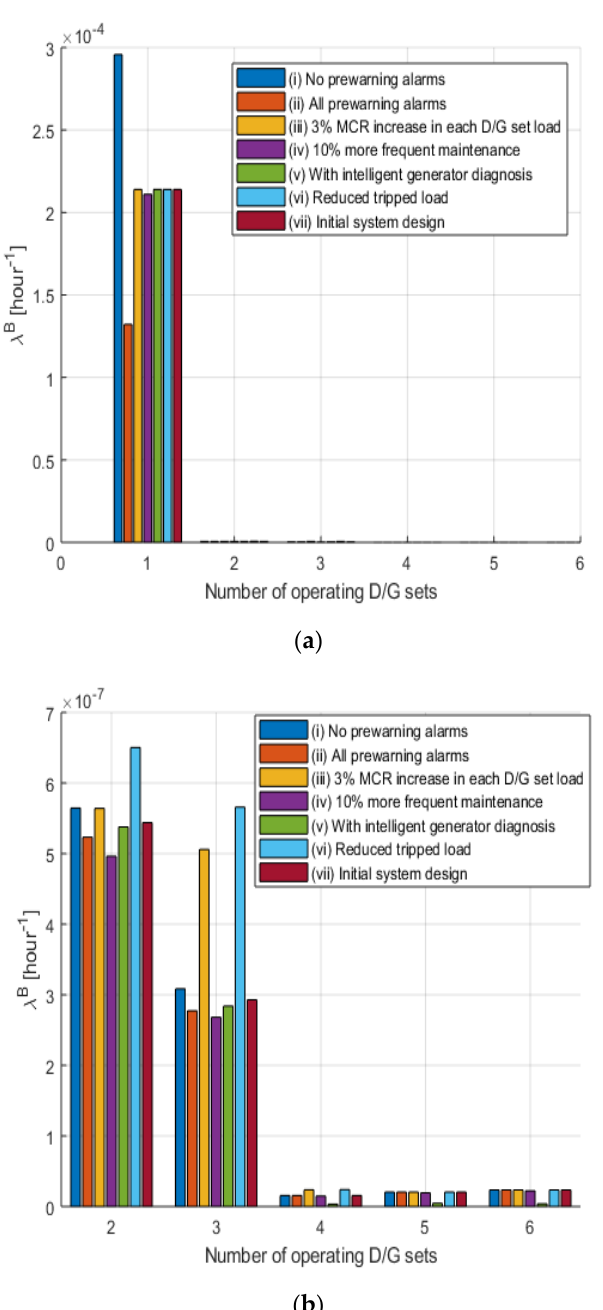
Figure 10. Blackout failure rate ( 𝜆 (cid:3003) ) for different total number of DG sets operating ( a ) 1–6 totally DG sets operating; ( b ) 2–6 totally DG sets operating (to be noted that the failure rate is much higher for 1 operating DG set